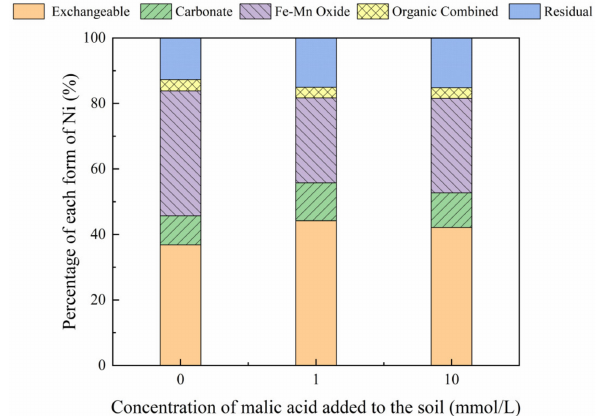
Figure 10. Distribution of different Ni forms in Ni-300 soil after the addition of malic acid (0, 1, 10